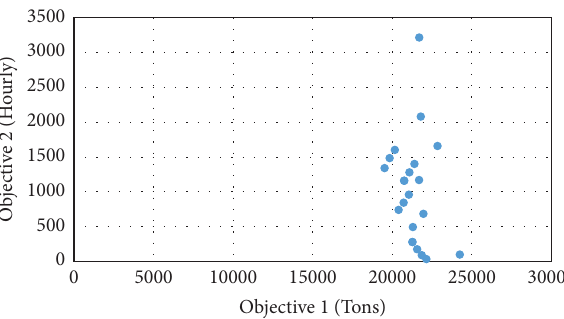
Figure 4: Space of the generated nondominate